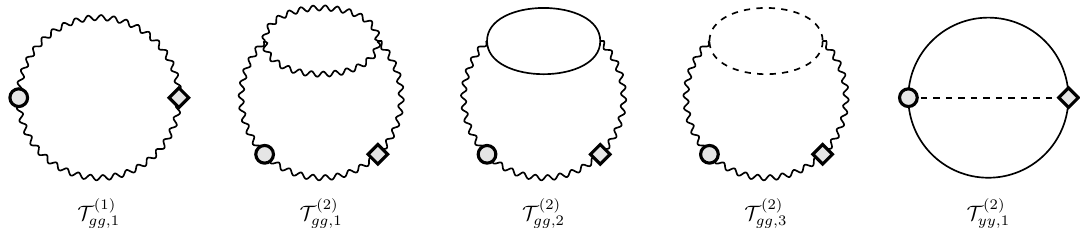
Figure 6 . Graph representation of the 1- and 2-loop contributions to T open index I and a diamond an index J .